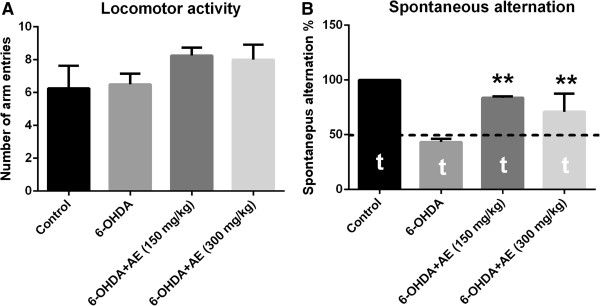
Effects of the aqueous extract of A. adianthifolia leaves (150 and 300 mg/kg) on spontaneous alternations% (B) and number of arm entries (A) in the 6-OHDA-treated rats. Values are means ± S.E.M. (n = 10 animals per group), **p < 0.001 vs. 6-OHDA alone treated-group.